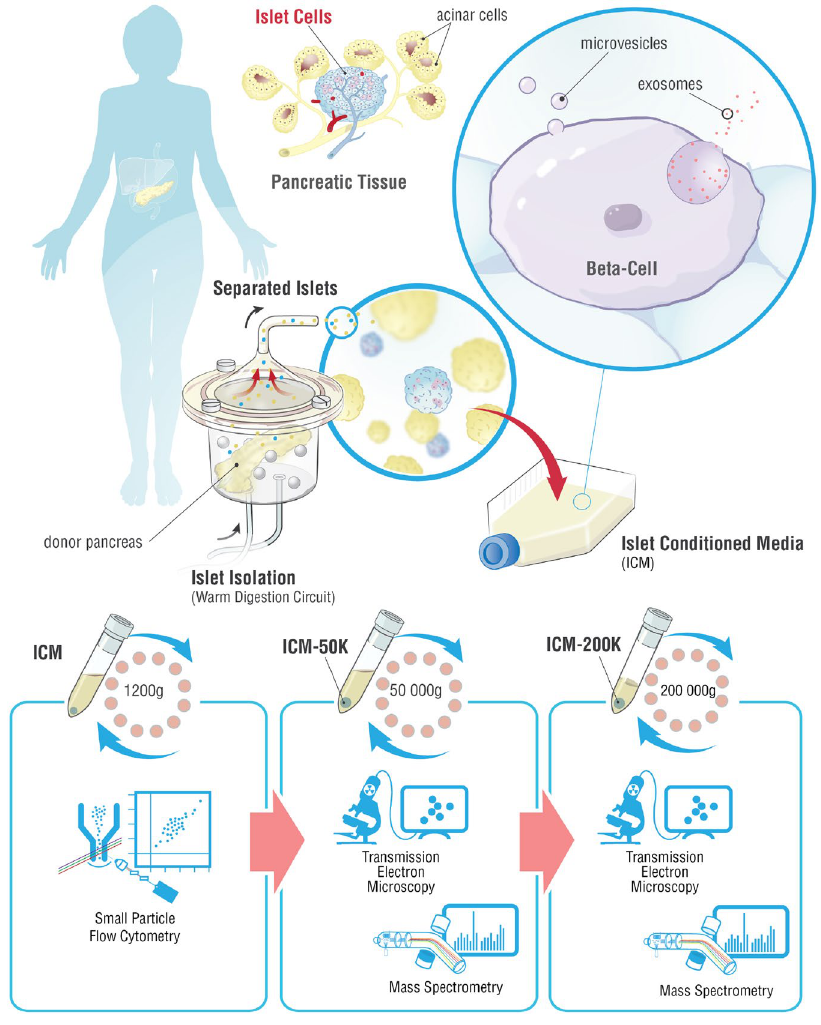
Figure 1. Schema describing the workflow to generate and analyze human islet conditioned media extracellular vesicles. Islet isolation was performed after the surgical retrieval of a donor pancreas. The pancreas was enzymatically digested in a closed loop circuit until free islets were observed. The islets were then purified, and cultured for up to 72 hours. Islet conditioned medium (ICM) was harvested, centrifuged at 1,200 × g for 15 min. and analyzed by small particle flow cytometry for DAA and markers of EV, or serially centrifuged a 50,000 × g and 200,000 × g for analysis by transmission electron microscopy or mass spectrometry on the ICM-50 K and ICM-200 K